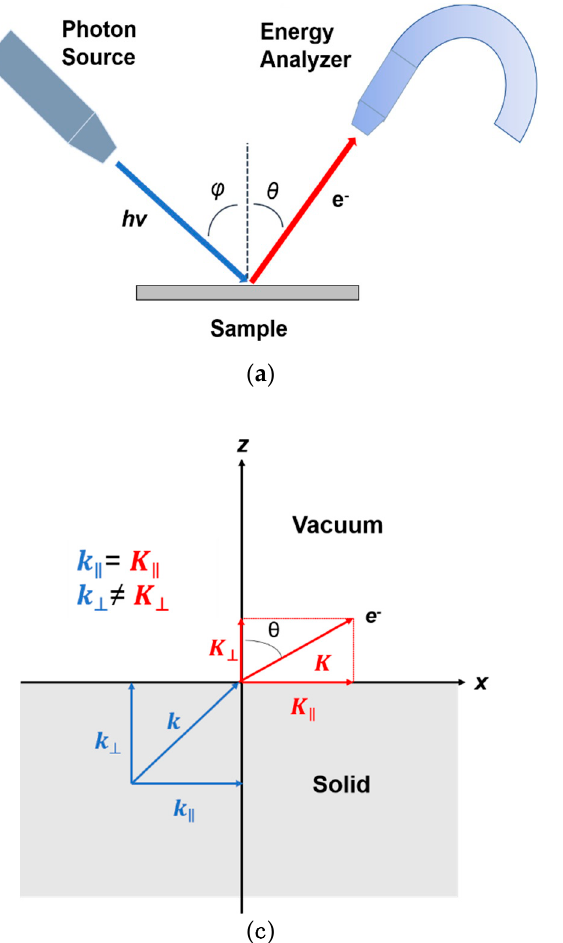
Figure 1. ( a ) Schematic of a photoemission experiment. The electrons are excited by the incident photons on the sample, then the excited electrons escape to the vacuum and are detected by an electron energy analyzer. ( b ) Schematic representation of photoemission spectroscopy (PES). The photoelectrons are excited from the occupied energy levels, including the valence bands as well as the core-level states. Additionally, secondary electrons excited by the photoelectrons that define the vacuum level cutoff are shown. ( c ) Photoemission geometry and relation of the electron wave vectors in vacuum ( 𝑲 ) and in solid ( 𝒌 ). Note that only the parallel momentum component is conserved.